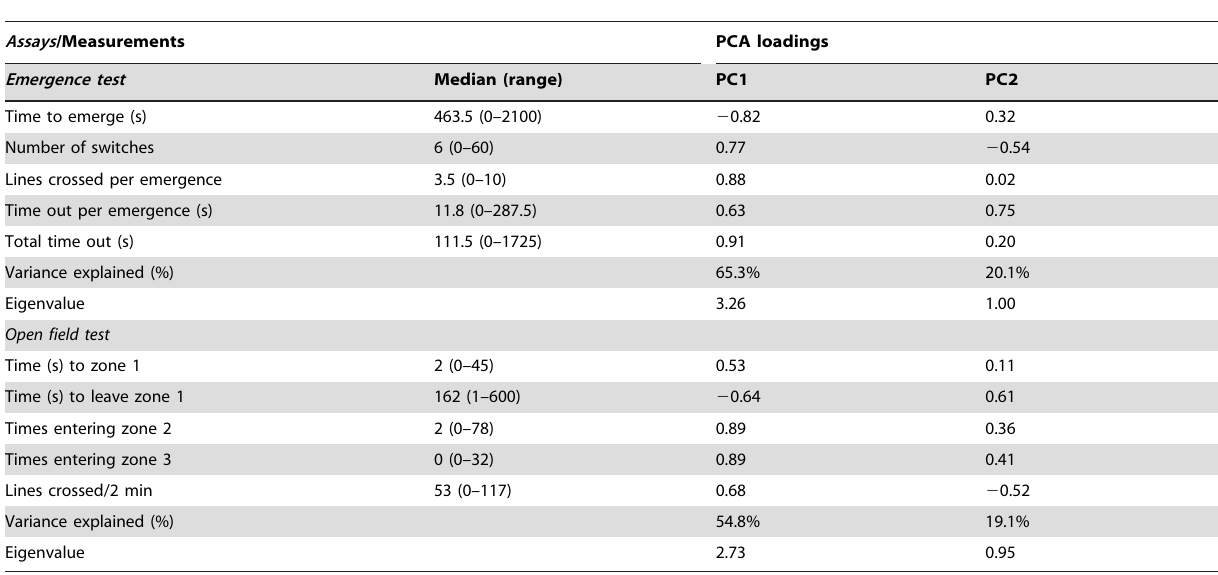
Table 2. Loadings for the two first principal component (PC1, PC2) of the measures included in principal component analyses.